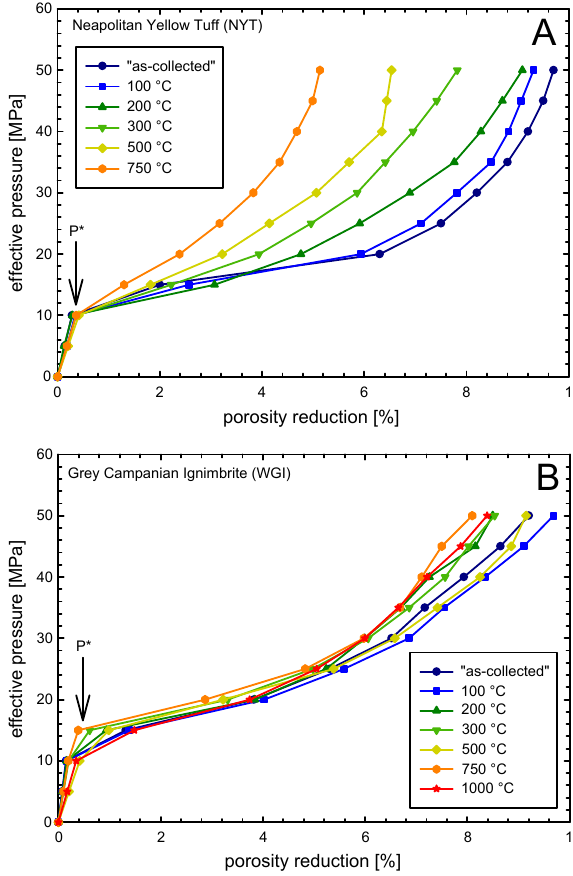
Fig. 5. The evolution of porosity change with increasing effective pressure for Neapolitan Yellow Tuff (A) and Grey Campanian Ig- nimbrite (B) . The temperatures in the legend refer to the thermal stressing temperature (see text for details). Note that the porosity reduction on the x axis is not a relative